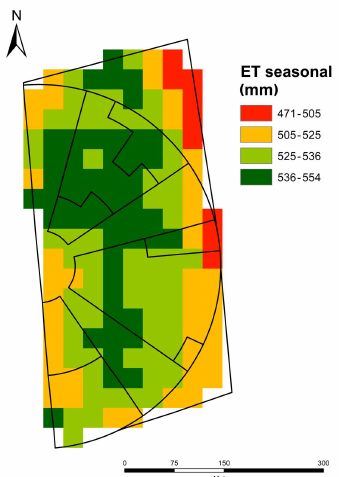
Figure 9. Map of seasonal ET (ET seasonal ) for the study area in 2015 during the growing season (April 13th to September 7th).